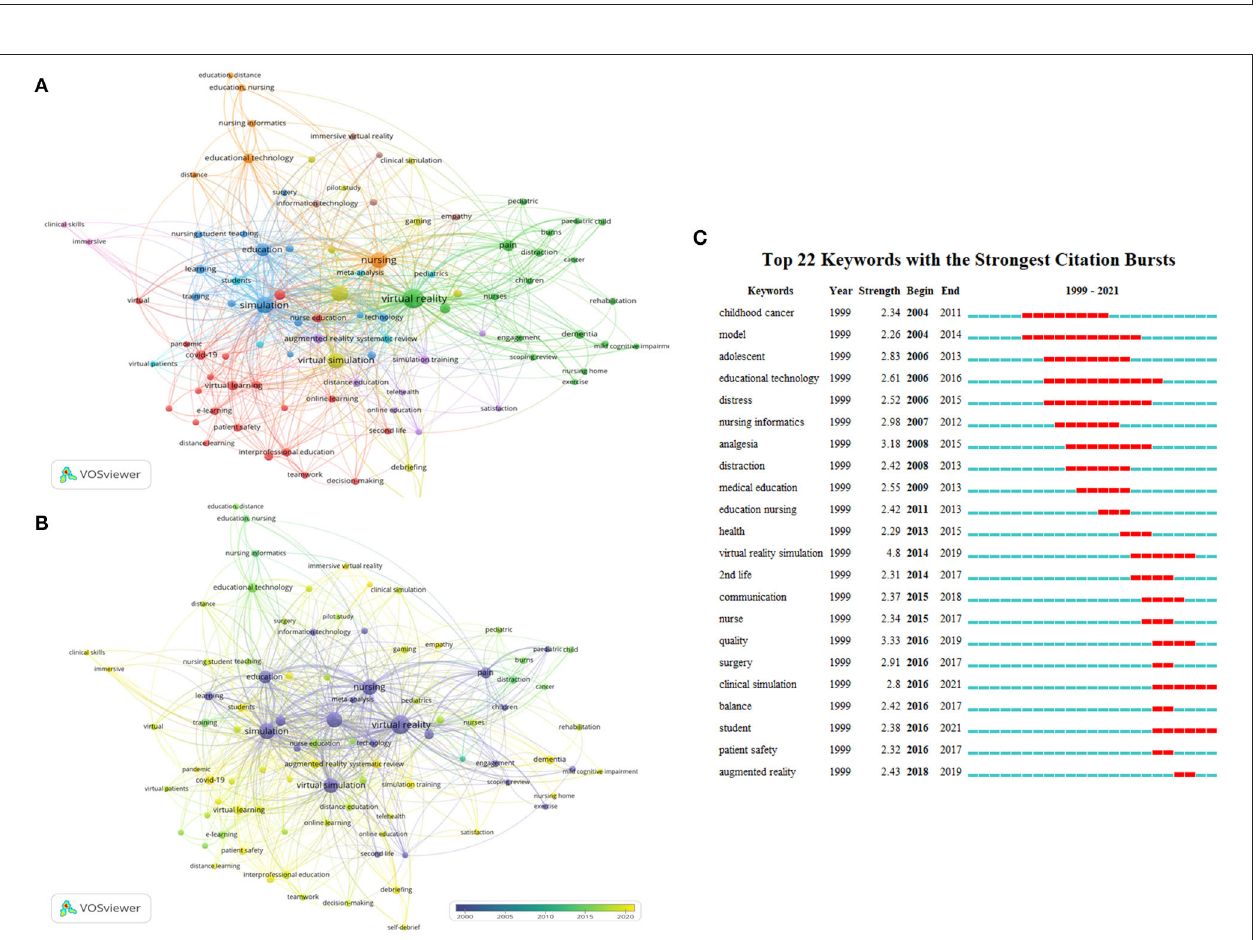
FIGURE 5 | Analysis of keywords related to publications of virtual simulation in nursing field. (A) The co-occurrence network visualization map of keywords related to virtual simulation in nursing field. The keywords clustered into nine groups according to their color. Large nodes represented keywords with high frequency; (B) Keywords were colored according to the appearance for the average time. The blue color represented for early stage and yellow color represented late stage. (C) The top 22 keywords with the strongest citation bursts on virtual simulation in nursing field between 1999 and 2021. The red segment of the blue line denoted the burst duration of a